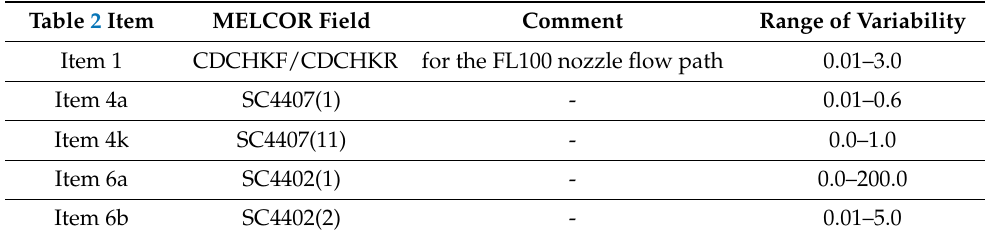
Table 3. List of the sensitivity parameters selected for the final analysis. Table 2